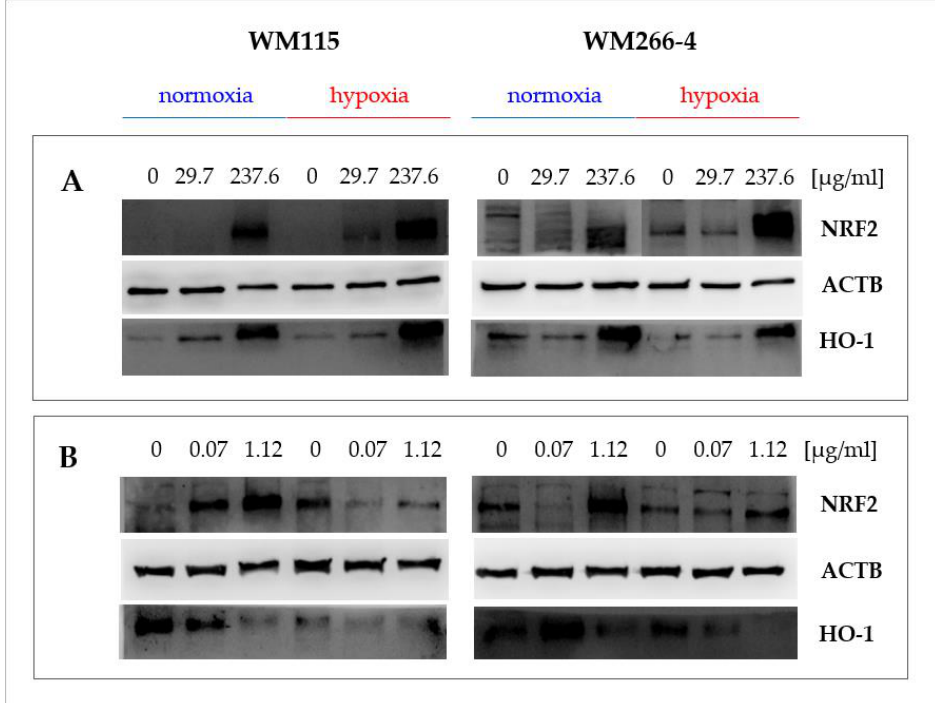
Figure 6. Effect of Hypericum perforatum extract HpEx2 ( A ) and hyperforin salt ( B ) on NRF2 and HO-1 protein expression in WM115 and WM266-4 melanoma cells cultured under normoxia and hypoxia, analyzed by the specific anti-NRF2 (16396-1-AP, Proteintech) and anti-HO-1 (ADI-SPA 894, Enzo) antibodies in Western